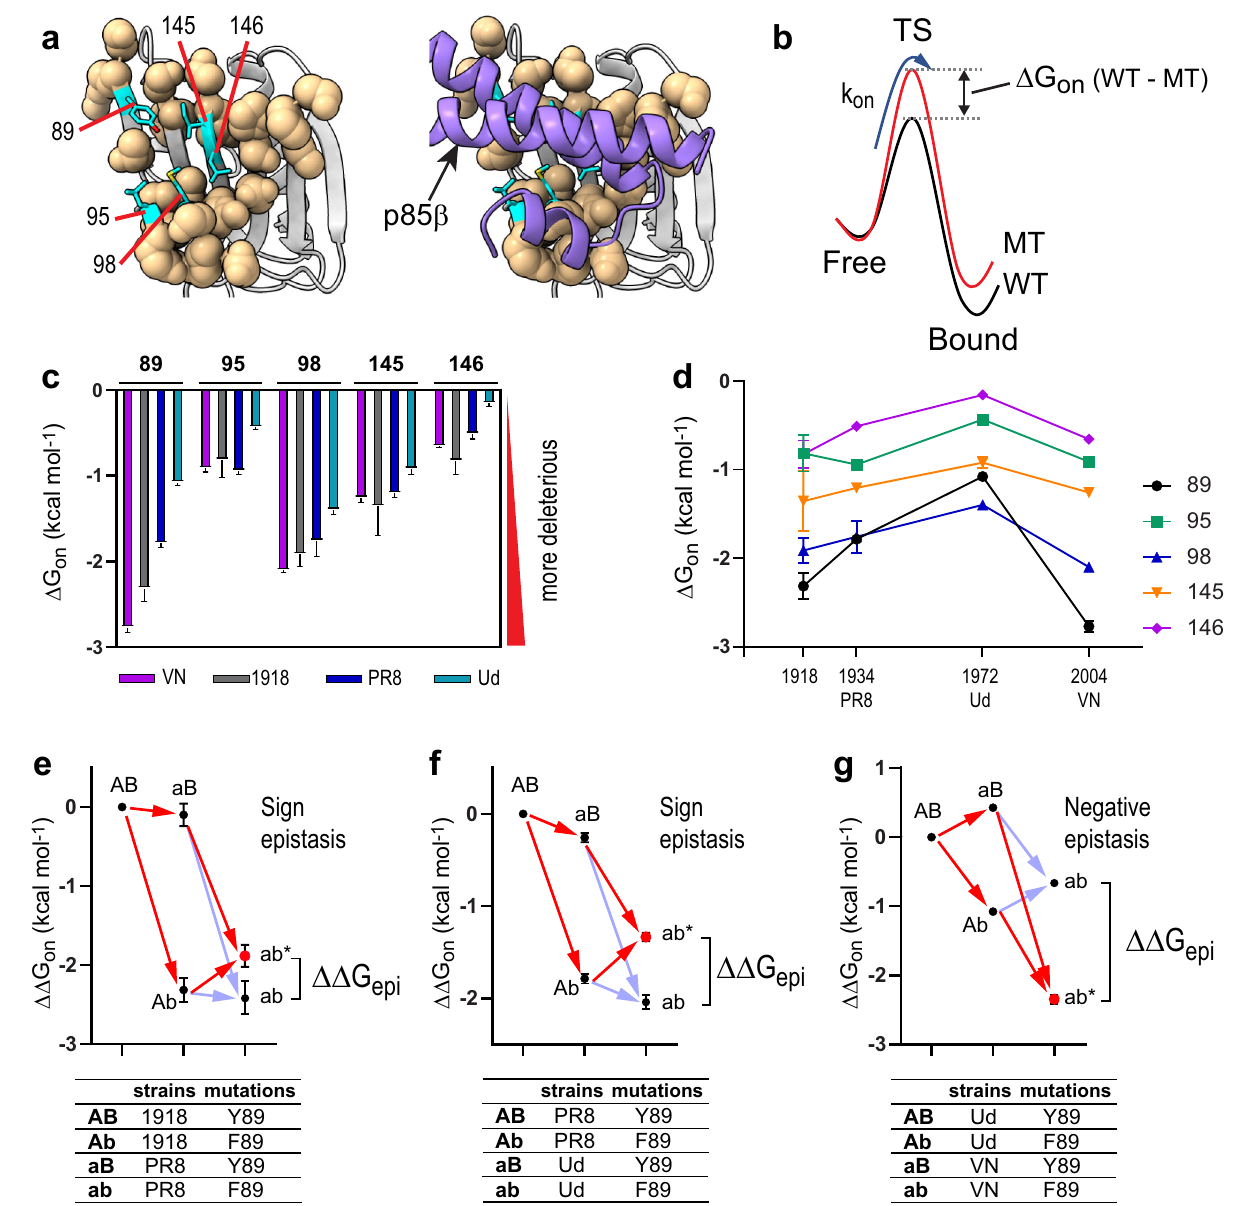
Fig. 2 | Strain-speci fi c epistasis in NS1s. a The core and rim interface residues are shown as cyan sticks and wheat spheres, respectively. b De fi nition of Δ G on (WT – MT)inthebindingreactioncoordinatebetweenNS1andp85 β .Negative Δ G on (WT – MT) indicates deleterious mutational effects on association kinetics (k on ). c Strain-speci fi c Δ G on of core interface residues. d Evolution of Δ G on of core interface residues as a function of years of the occurrence of IAV strains. e – g Epistatic interactions ( ΔΔ G epi ) between strain-speci fi c mutations (A → a) and mutations of individual core interface residues (B → b). ab* corresponds to the experimentallymeasuredeffectsofdoublemutations,whileabcorrespondstothe